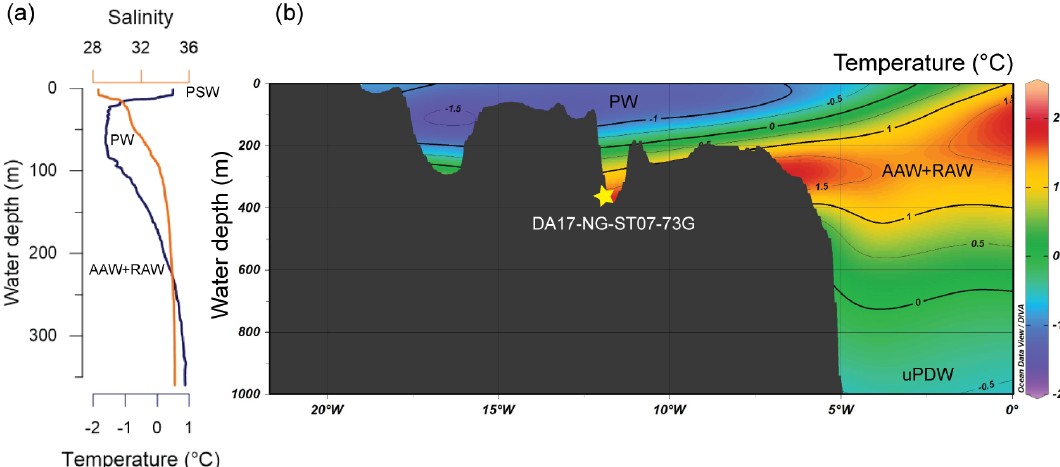
Figure 2. (a) Temperature and salinity profile of the water column at the coring station (79.073 ◦ N, 11.918 ◦ W) obtained during the North- Green17 expedition, showing the main water masses. (b) Annual average temperature of the water column in the upper 1000m along a transect at 78.876 ◦ N, showing the main water masses at the study site. Polar Surface Water (PSW), Polar Water (PW), combined Arctic At- lantic Water (AAW), Return Atlantic Water (RAW), and upper Polar Deep Water (uPDW) are shown. The yellow star indicates the location of the core site at 385m water depth. Temperature data are taken from the World Ocean Atlas 2018 (Boyer et al., 2018). The location of the transect is marked as a black line in Fig.